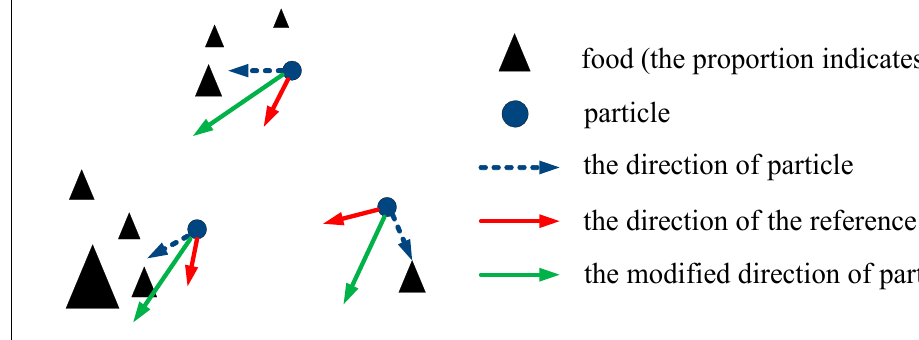
Figure 1. Schematic of PSO search